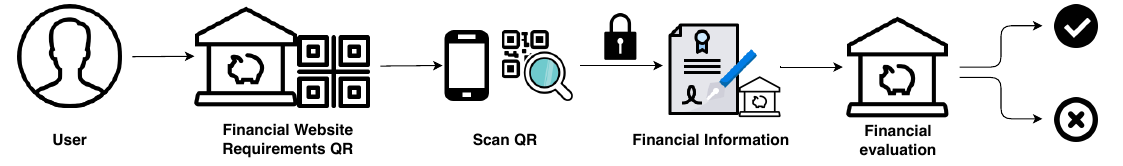
Figure 3. High level overview of Credit File use